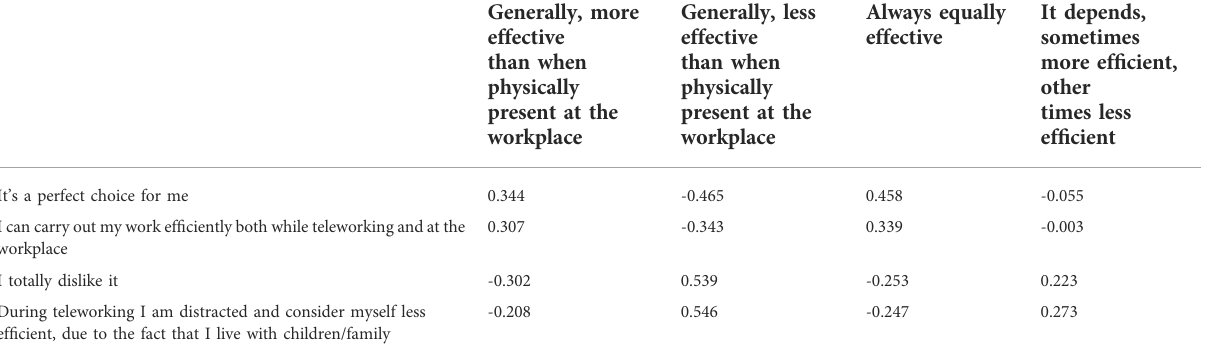
TABLE 8 Pearson correlation coef fi cients for execution functions.